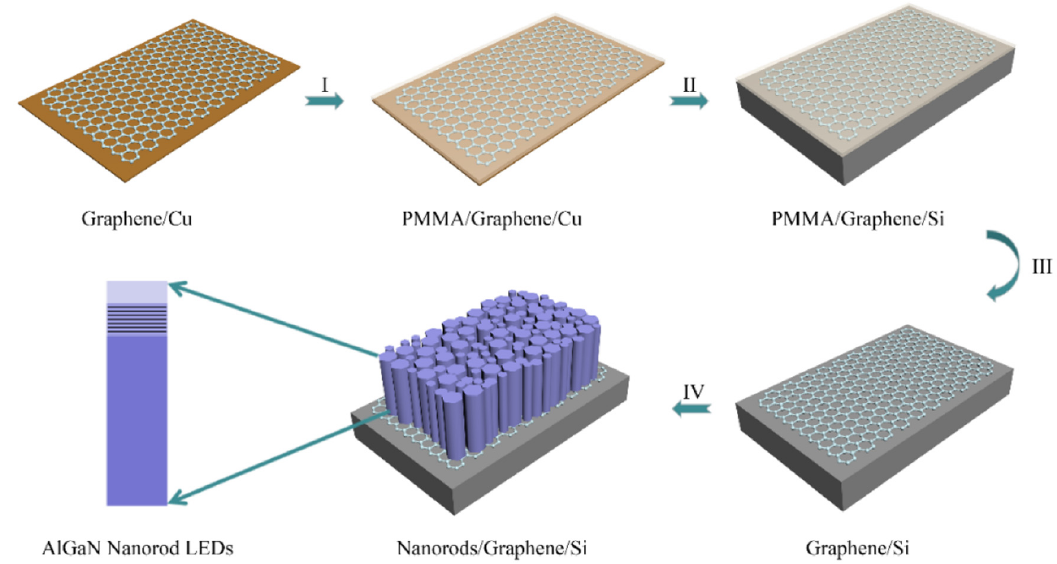
Figure 1. Schematic representation of the graphene transfer procedure and the key processes involved in metal organic chemical vapor deposition (MOCVD) for growing AlGaN nanorod LEDs. (I) spin coating of poly methyl methacrylate (PMMA) on graphene on Cu foil; (II) the transfer of graphene with PMMA to Si substrate; (III) dissolution of PMMA; and (IV) MOCVD growing of AlGaN nanorod LEDs. Reprinted with permission from Ref. [52]. Copyright 1996–2022 MDPI (Basel, Switzerland).